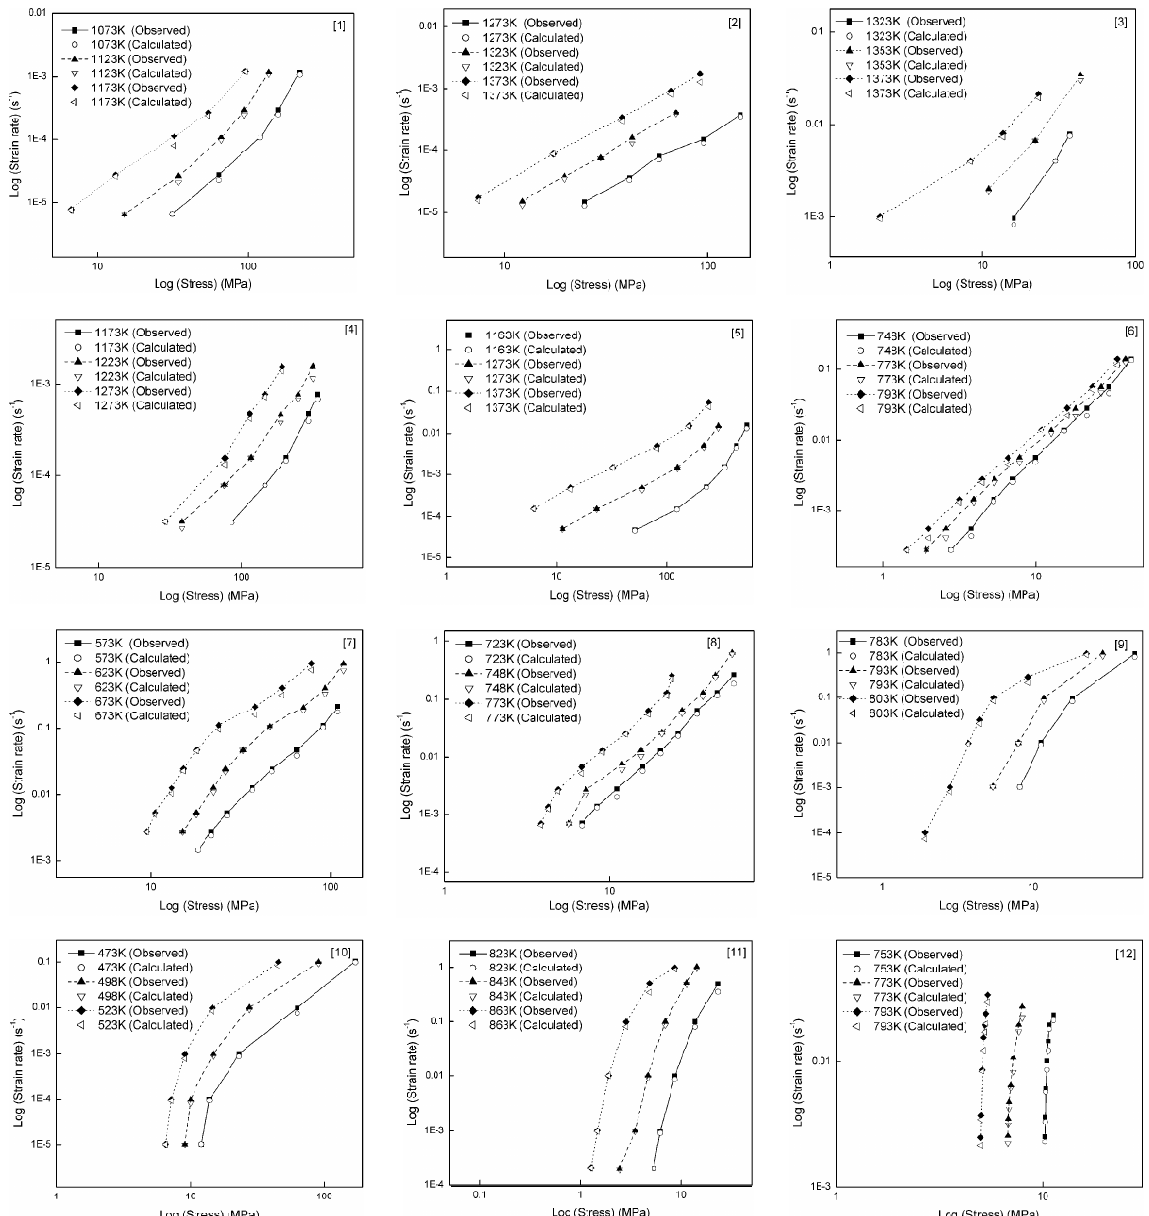
Fig. 5. Strain rate as a function of flow stress at different temperatures for the alloys numbered 1-12 in the Appendix. Experimental data are connected by curves. Calculated values were obtained using Eq.